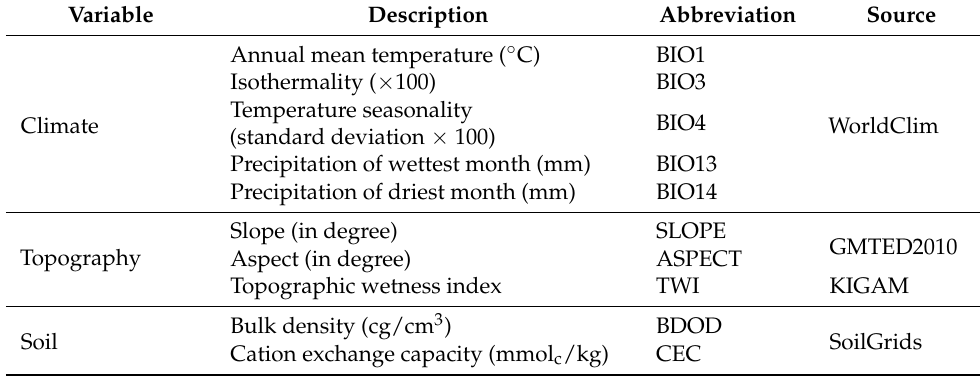
Table 2. Environmental variables used in the species distribution